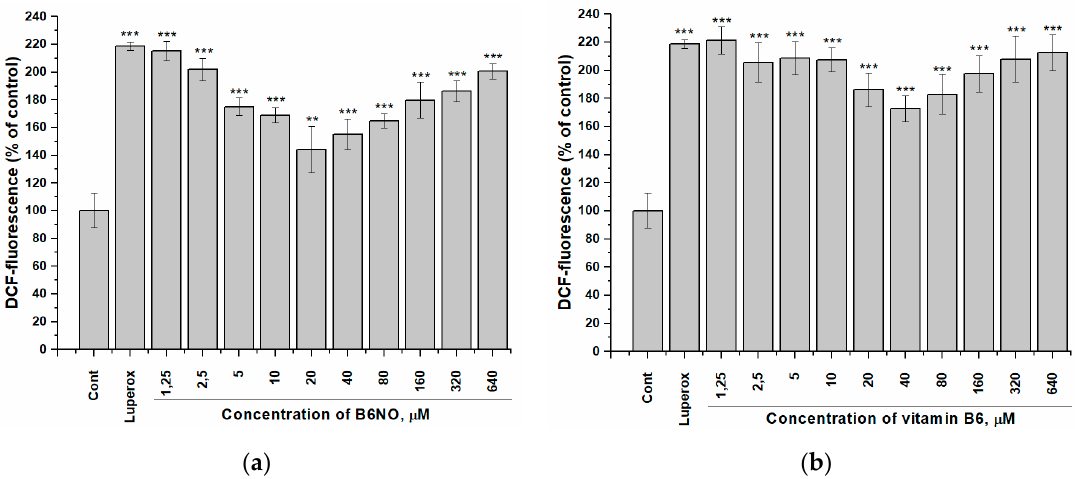
Figure 6. Influence of B6NO and vitamin B6 on the intracellular ROS formation initiated by tert -Butyl peroxide in HepG2 cells and measured using the DCFH-DA assay. Cells were treated with 25 μ M tert -Butyl peroxide (Luperox ® ) for 30 min and pre-treatment with ( a ) B6NO or ( b ) vitamin B6 at 1.25 − 640 μ M for 24 h. Significant differences are shown as ** p < 0.01; *** p < 0.001.